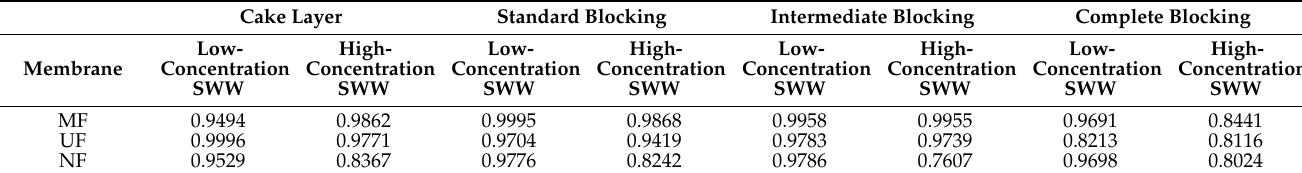
Table 2. R 2 of single model fitting for gradient filtration of